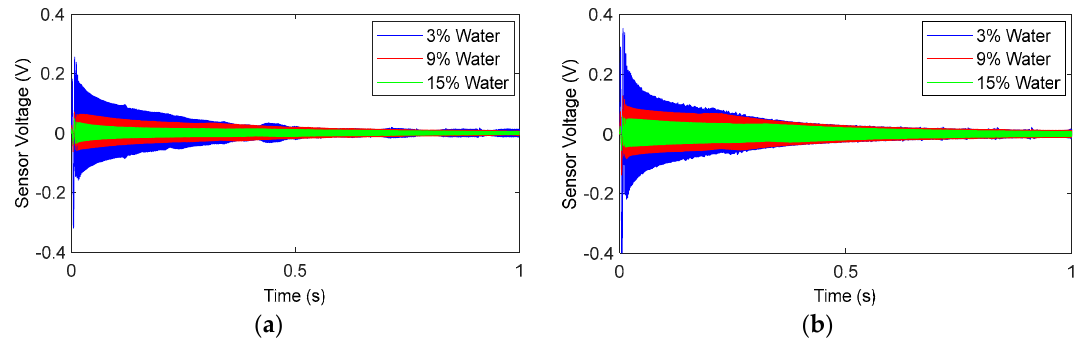
Figure 5. Time-domain signal response of the two test specimens. ( a ) Specimen 1, ( b ) Specimen 2.